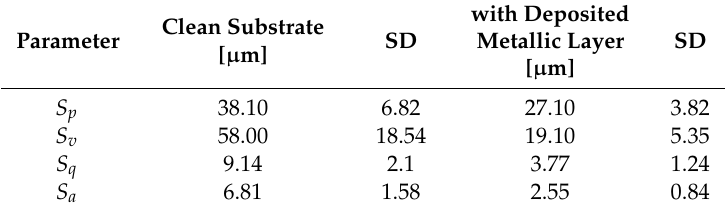
Table 4. Results of roughness measurement obtained using a profilometer.